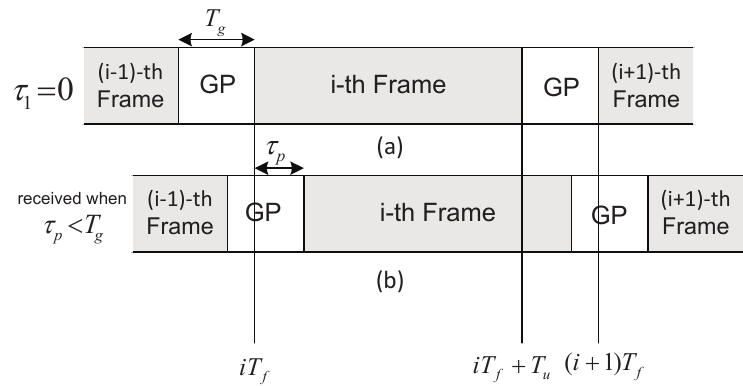
Figure 2. ( a ) Received frame from the shortest multipath component and ( b ) Received frame from the p -th path with τ p < T g .